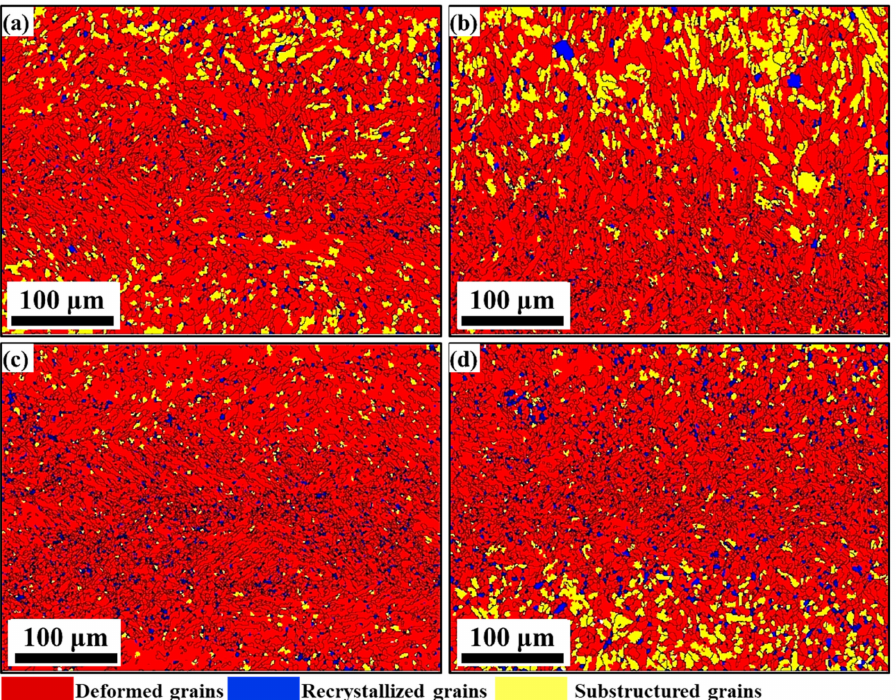
Figure 12. Color IPF maps illustrating the DRX grains (in blue), deformed grains (in red) and sub- grains (in yellow) at a strain rate of 0.1s − 1 with ( a ) without ultrasonic 950 ◦ C, ( b ) without ultrasonic